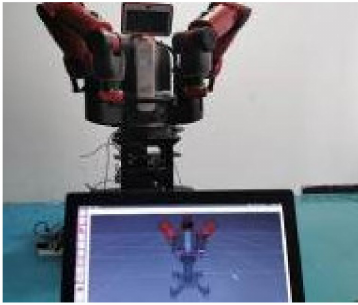
Figure 19. Original state.